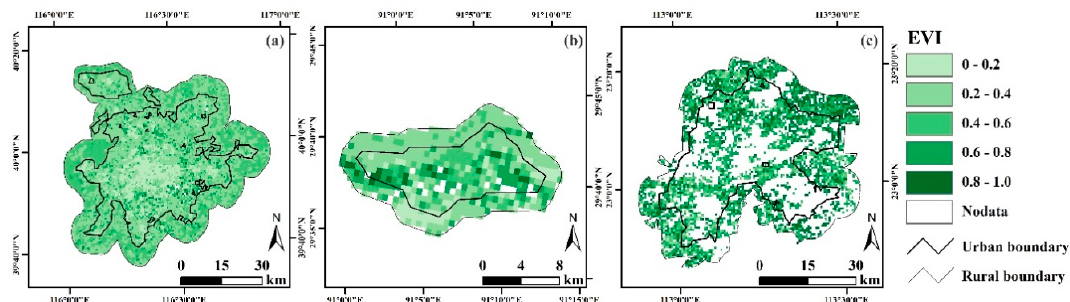
Figure 2. The EVI values corresponding to the dormancy onset date from the product MCD12Q2 in three enlarged examples to show vegetation configuration. The EVI was the mean value from 2011 to 2014 to mitigate the uncertainty from annual fluctuations. The enlarged examples are ( a ) Beijing in the temperate climate zone; ( b ) Lhasa in the Tibetan-plateau climate zone and ( c ) Guangzhou in the tropical/subtropical climate zone. Please refer to Figure 1 for their locations in China.